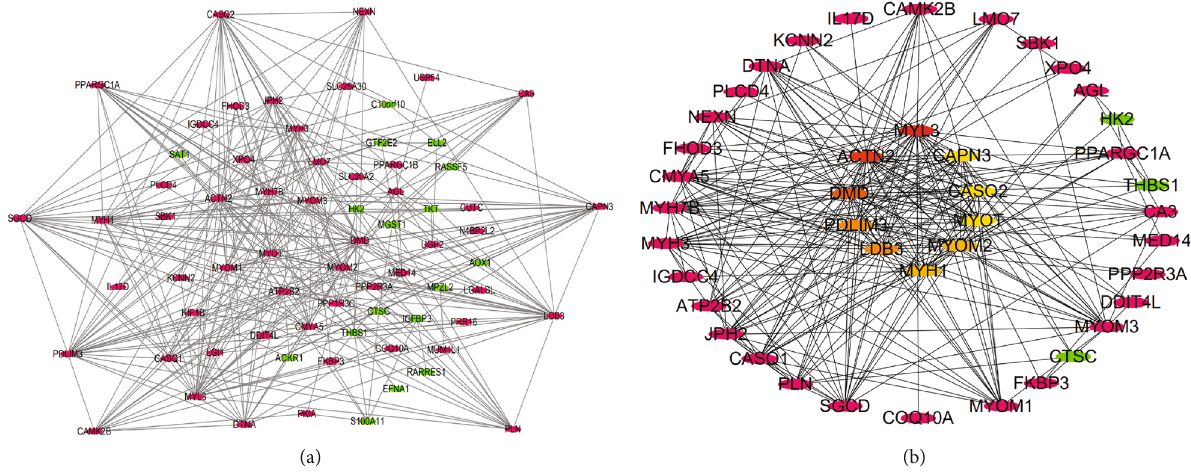
Figure 6: Hub gene identi fi cation. (a) A DEG PPI network constructed using Cytoscape, with upregulated and downregulated genes being shown in red and green, respectively. (b) The top 10 genes with the highest degree values were identi fi ed using CytoHubba. These genes were ranked in descending degree order from red to orange to